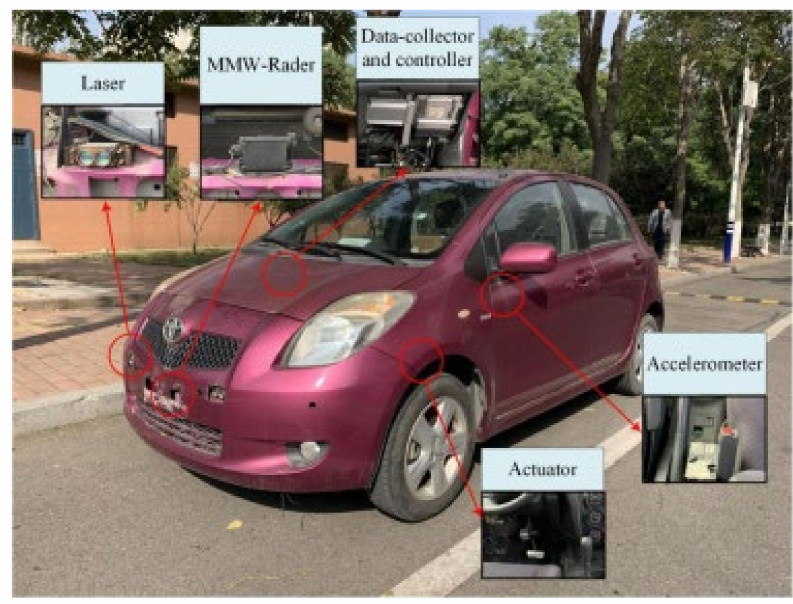
Figure 3. Configuration of the test